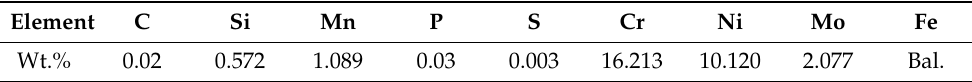
Table 1. Chemical compositions of